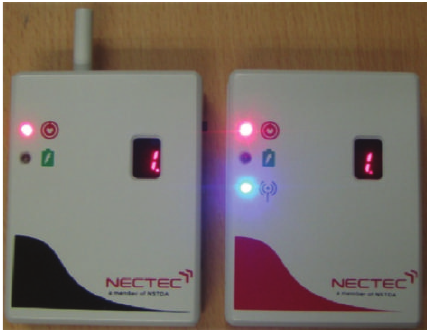
Figure 5: Transmitter and receiver casing.